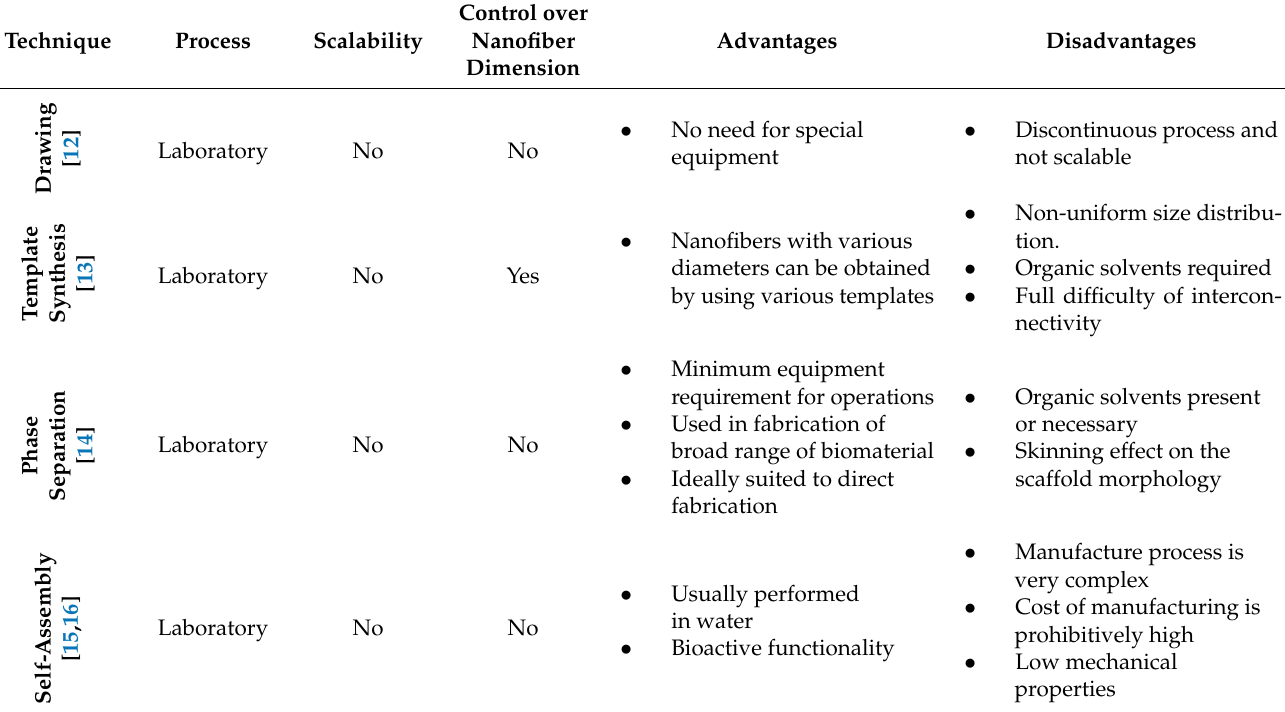
Table 1. Comparison between different methods of nanofiber production.